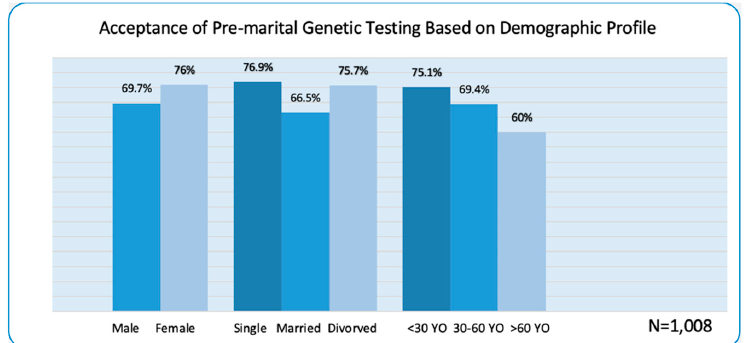
Figure 1. Acceptance to Premarital Genetic Testing Based on Demographic Profile.